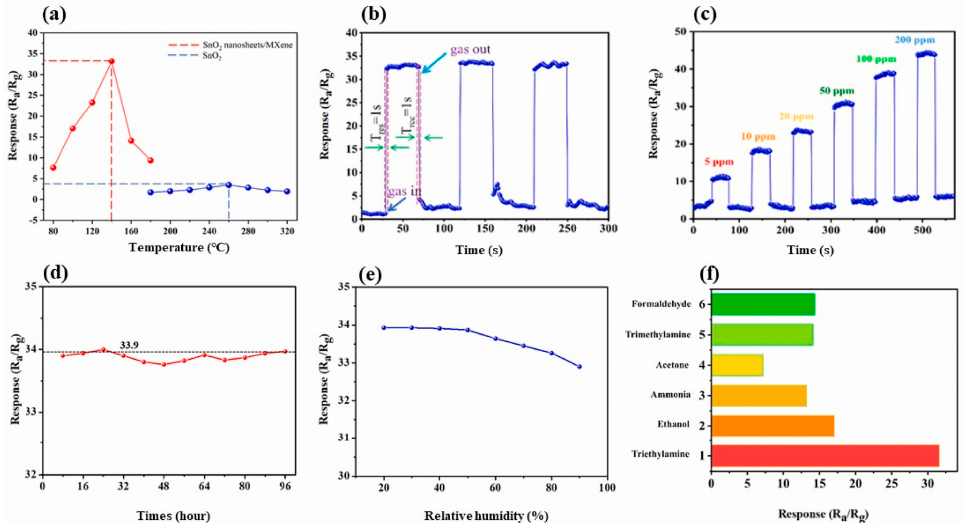
Figure 15. ( a ) Gas-sensing response of SNTM composites and pure SnO 2 based sensor to 50 ppm of triethylamine (TEA) at diverse operating temperatures. ( b ) Reproducibility, response, and recovery characteristics of SNTM composites based on sensors upon exposure (3 cycles) to 50 ppm TEA gas at 140 °C. ( c ) The dynamic response and recovery curves of SNTM composites-based sensor to TEA with the increasing concentrations. ( d ) Stability of the sensor on successive exposure to 50 ppm TEA at 140 °C; ( e ) Sensor response of SNTM to 50 ppm TEA at various humidity conditions. ( f ) The selectivity of the SNTM composites-based sensor to different gases at 50 ppm TEA. Reprinted with permission from [119]. Copyright 2022: Elsevier B.V.